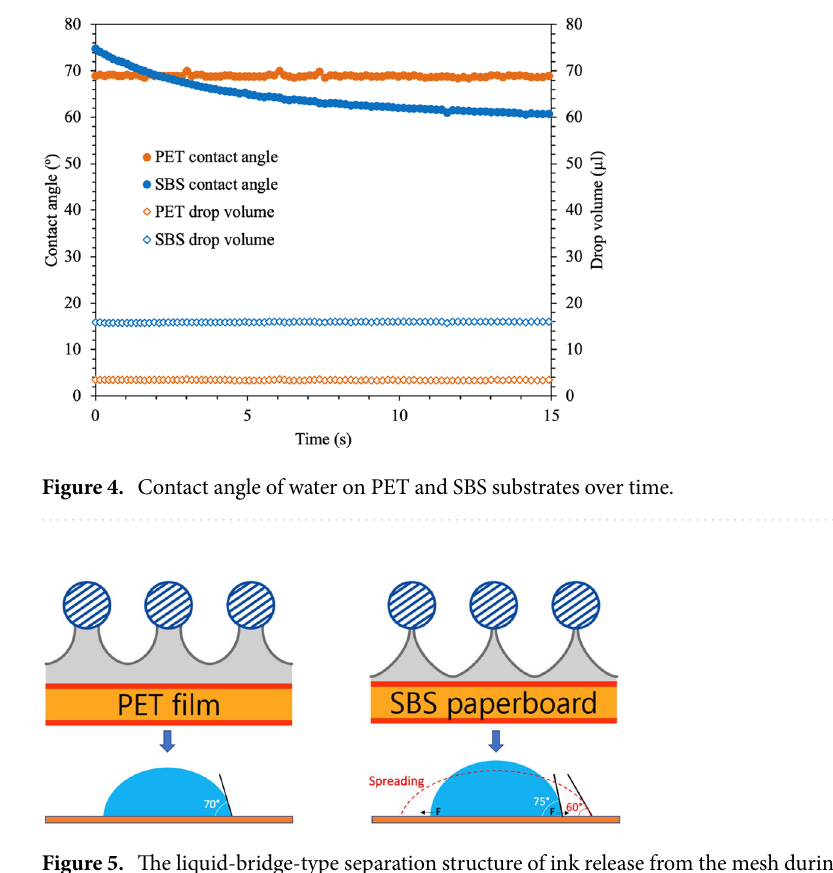
Figure 5. The liquid-bridge-type separation structure of ink release from the mesh during lifting of the tensioned mesh from the substrates: PET vs. SBS.